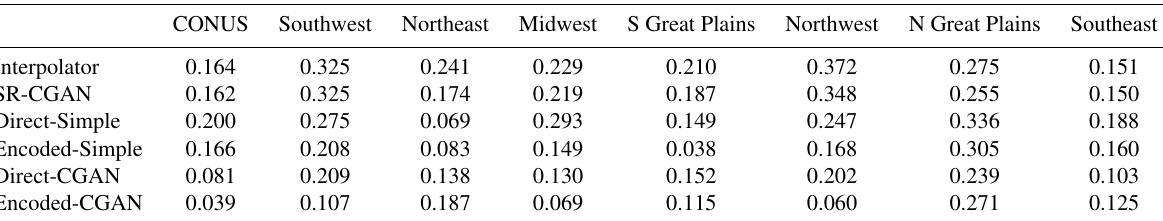
Table 3. J–S distance (Eq. 3) measuring the similarity of the PDFs between Ground Truth and six predictive models (Interpolator and CNN-based models) over CONUS and seven subregions.